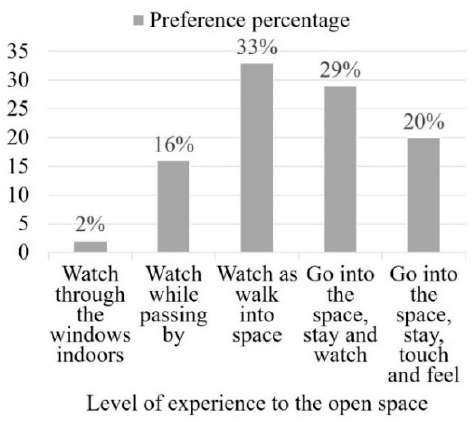
Figure 5. Interaction level of visit preference.